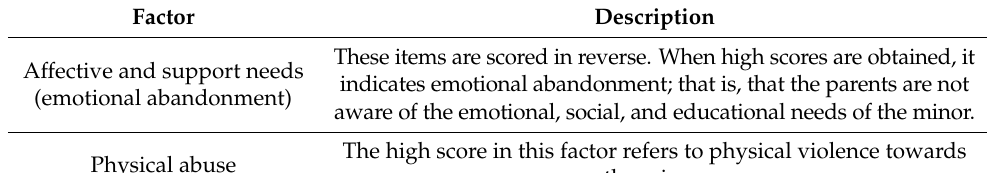
Table 2. Factors of child